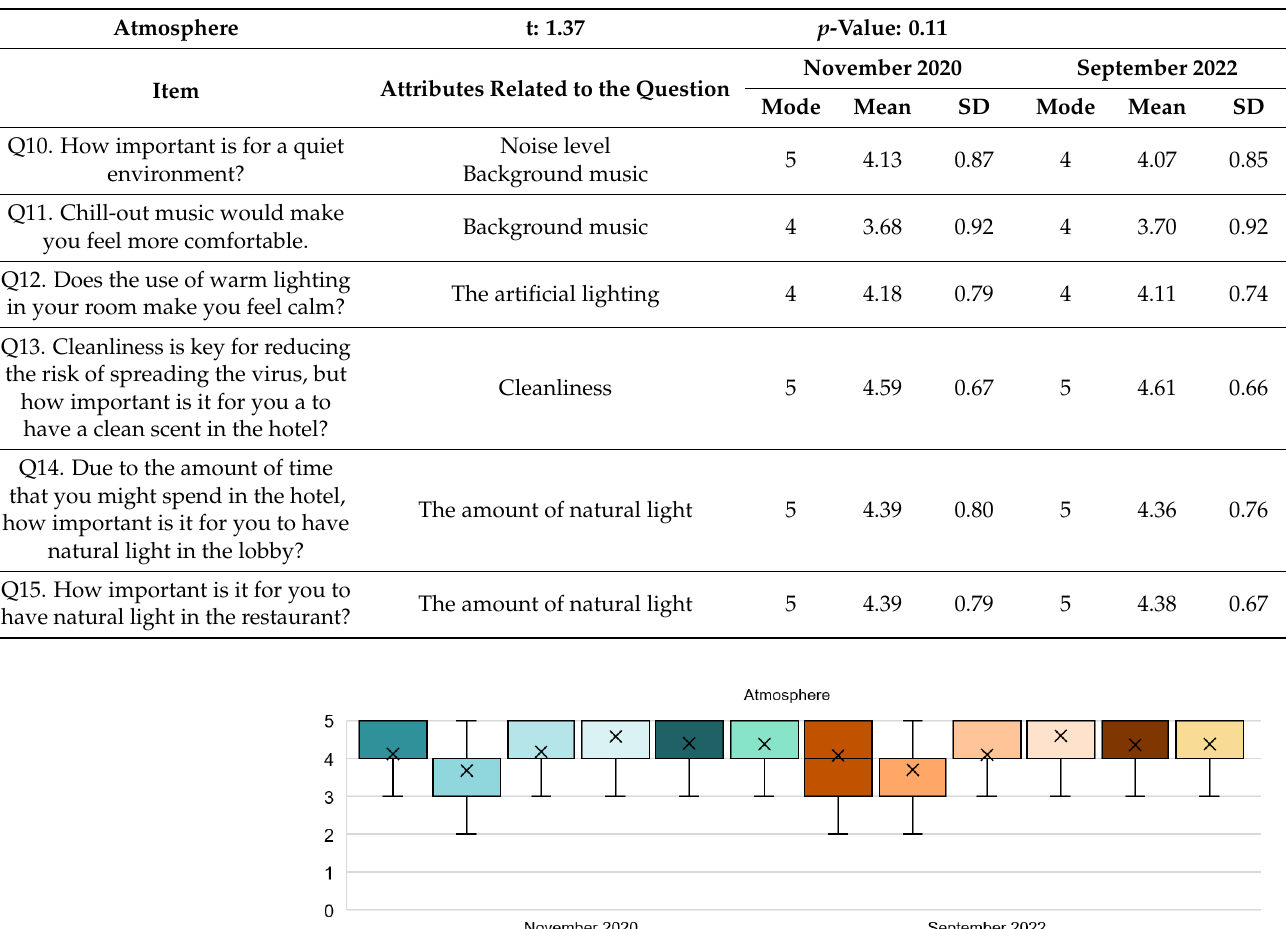
Figure 4. Functionality dimension chart. Table 4. Interval data analysis of the Atmosphere dimension.